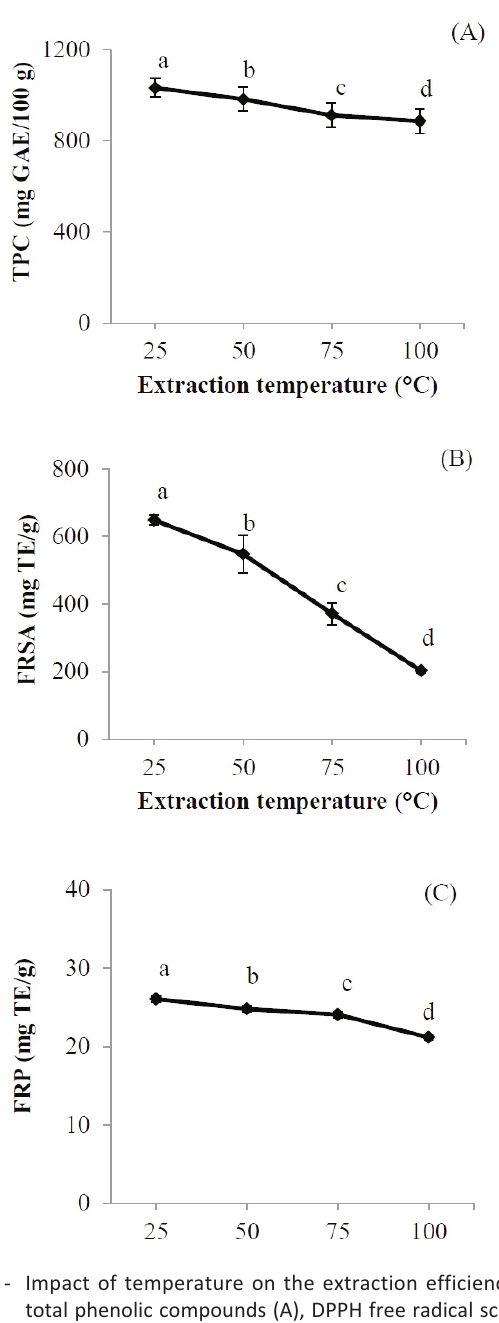
Fig. 1 ­ Impact of temperature on the extraction efficiency for total phenolic compounds (A), DPPH free radical scanen­ ging activity (B) and ferric reducing power (C) of eggplant (n= 2). Values with different letters are significantly diffe­ rent